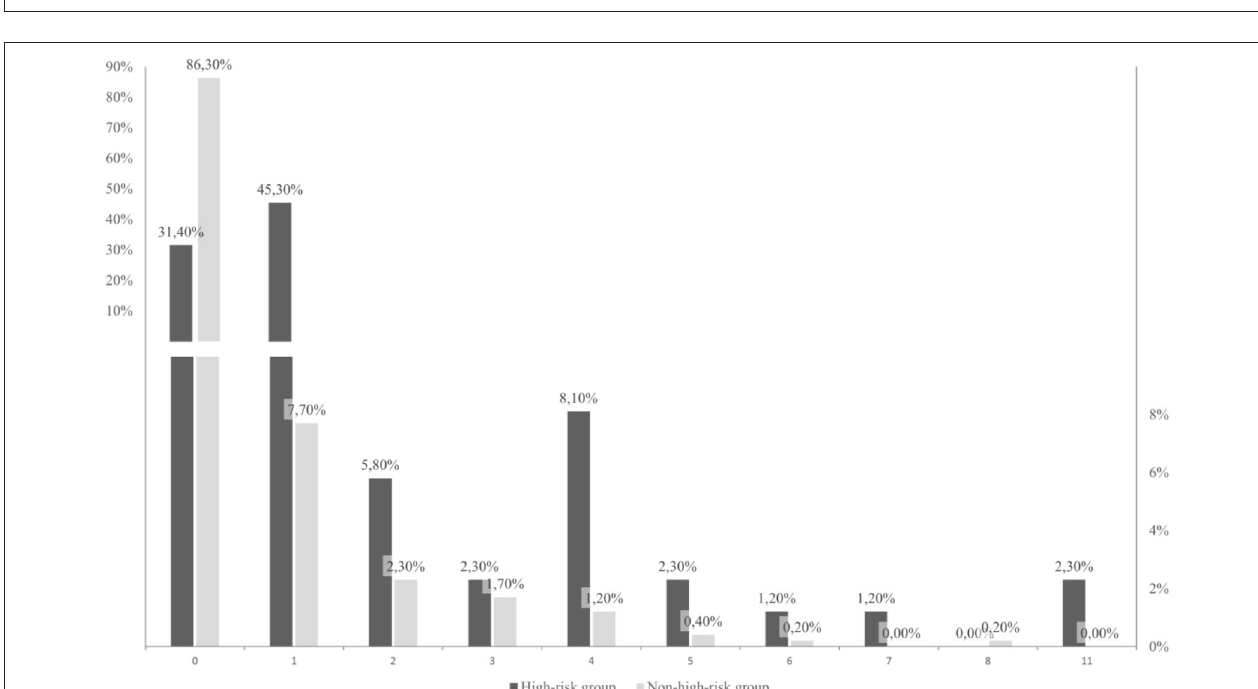
FIGURE 2 | Percentage distribution of psychological interventions between the experimental groups (high-risk and non-high-risk). The chart is using a finer scaling until 10% to display smaller percentages. Significant difference ( N = 1,510, Pearson chi-squared test = 13.844, p < 0.01) was found with regards to admission to inpatient psychiatric treatment. In the comparison group, n = 33 out of N = 899 people (3.7%) and in the experimental group, n = 4 out of N = 611 people (0.6%) required inpatient